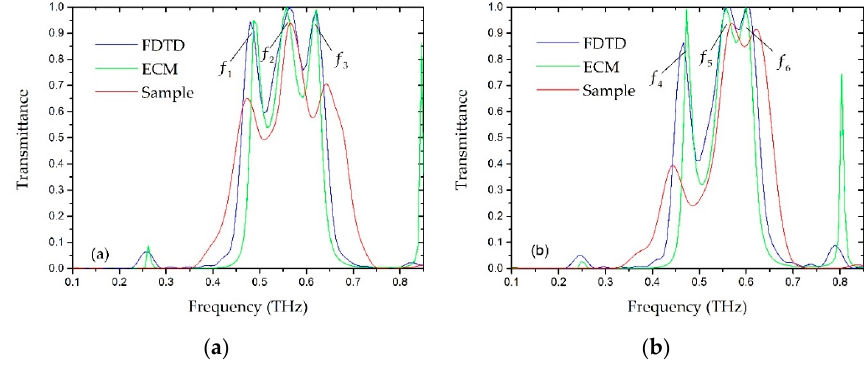
Figure 2. Comparison between the experimental, equivalent circuit model (ECM), and Finite-Difference Time-Domain (FDTD) results for spacing d = 555 μ m ( a ) and 585 μ m ( b ).